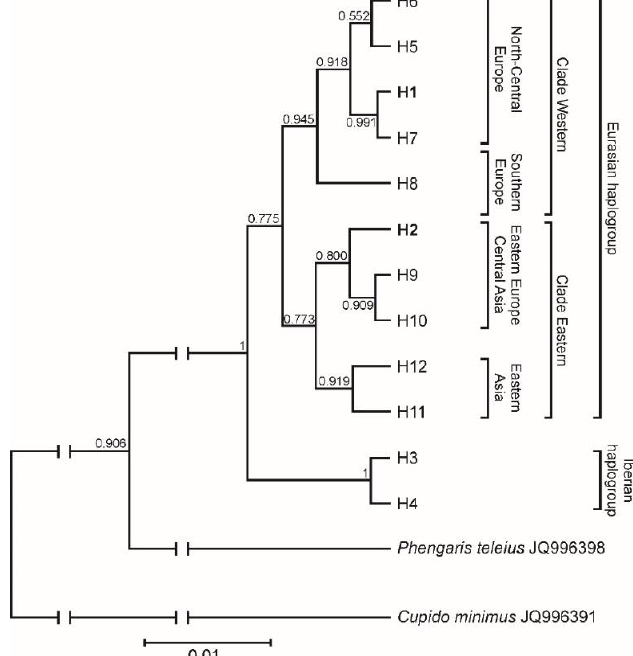
Figure 1. Phylogenetic Bayesian coalescent reconstruction analysis of the subset of mtCOI sequences consisting of distinct haplotypes noted in Polish populations (H1, H2) of Scolitantides orion , as well as sequences available in the GenBank database (H1, H3-H12). The tree has been rooted with sequences of the small blue ( Cupido minimus , JQ996391) and the scarce large blue ( Phengaris teleius , JQ996398). Insects 2020 , 11 , x FOR PEER REVIEW